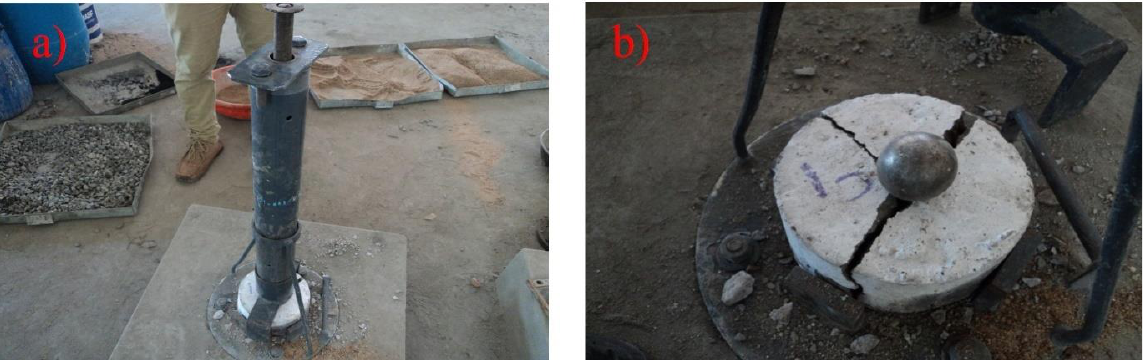
Figure 2. Impact test set-up. ( a ) Initial crack; ( b ) Final failure.